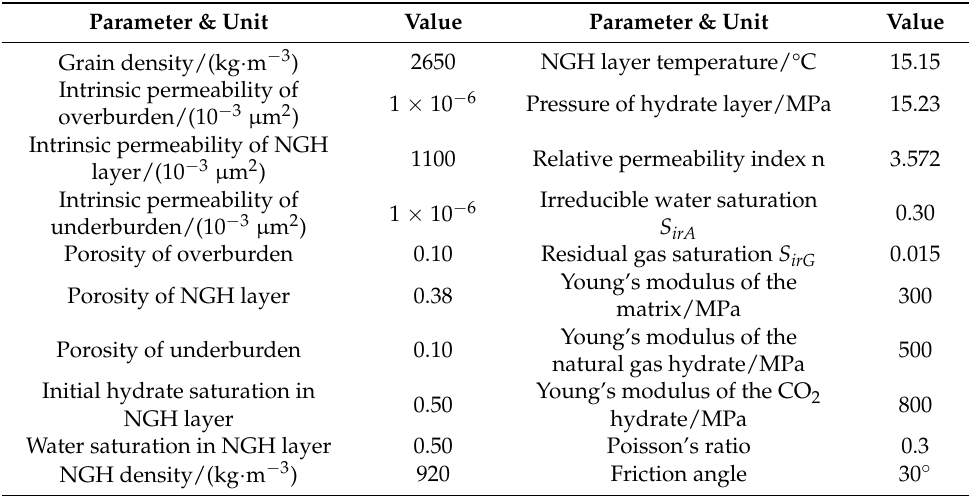
Table 1. The main parameters used in the numerical simulation.